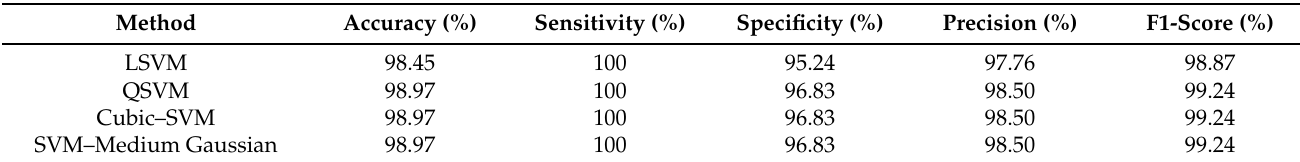
Table 9. DenseNet201 and CNN activated feature fusion based classification using 70%-30% split. Method